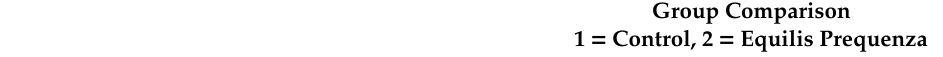
Table 2. Inferential statistics: comparison of the rectal temperature, clinical observations, and viral shedding between groups after challenge (mean e ff ect between 1 and 14 dpc a or 1 and 7 dpc b ). Group Comparison 1 = Control, 2 = Equilis Prequenza Parameter 2 vs. 1 0.0156